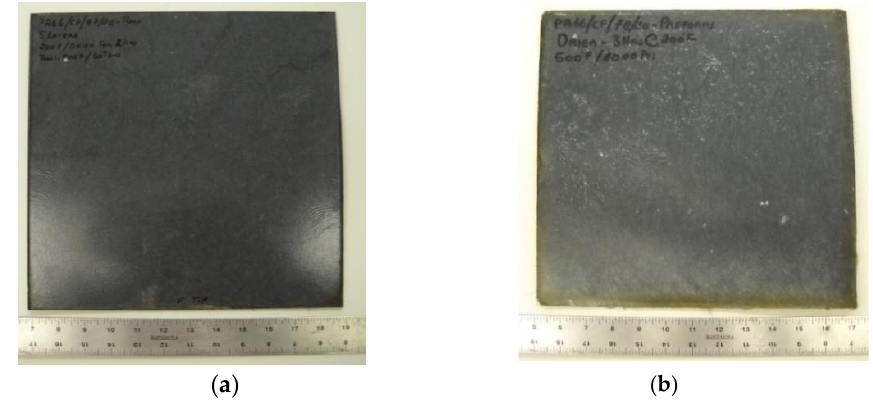
Figure 2. ‘Roll’ and ‘Sheet’ form panel; ( a ) ‘Roll’ form panel—optimal compression-molded C/PA66 panel from WL mats; ( b ) panel produced from WL PA66-CF mats in ‘sheet’ form. Panel size 300 × 300 mm 2 .